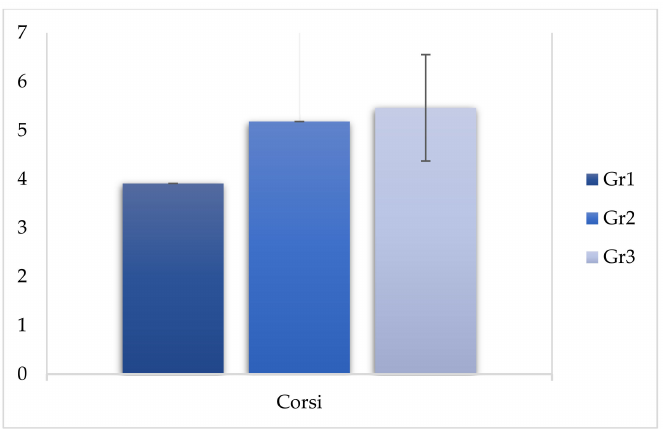
Figure 3. Comparison of Corsi between the three groups.